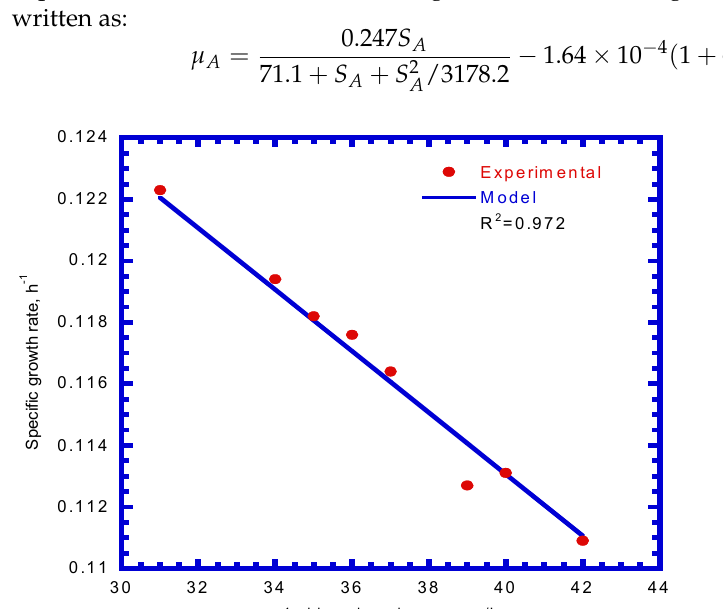
Figure 7. Model-fitted specific growth rates on binary substrates of sodium salicylate and 4-CP com- pared with experimental data to determine the decay constant of P. putida cells due to 4-chlorophe- nol ( m d,CP ).